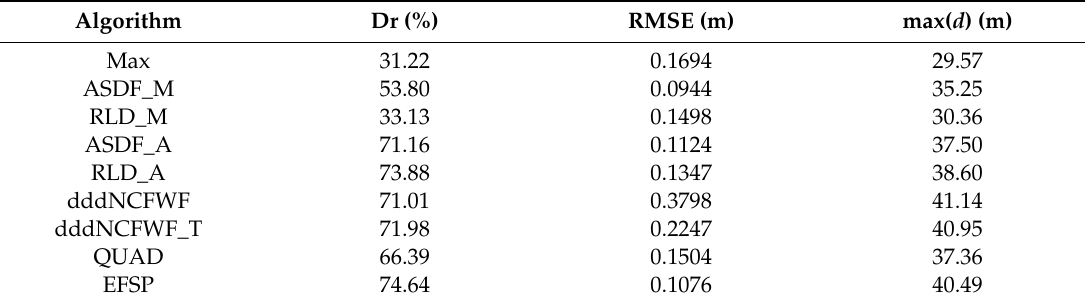
Table 3. Performance assessments for bottom detection results with field